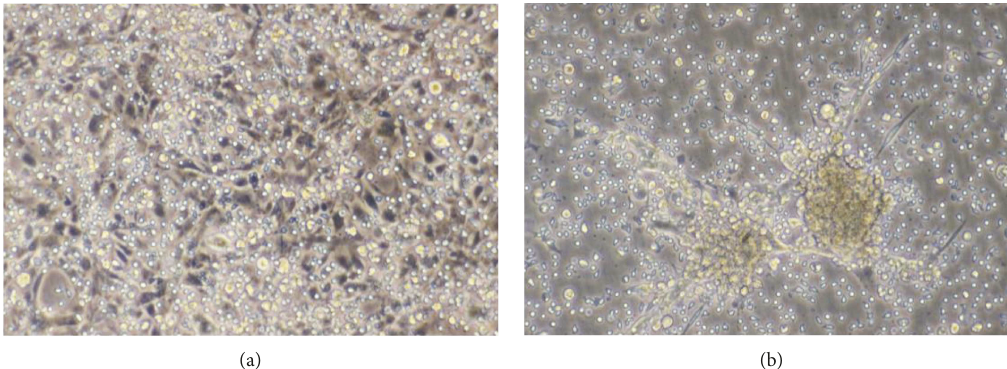
Figure 1: NK cytotoxicity against 2A2 pig endothelial cells. (a) Monolayers of porcine endothelial cells (pEC) were cultured to con fl uence and a suspension of IL2-activated puri fi ed polyclonal NK cells (bright round cells) was added on top of the monolayer, always in the absence of human sera. (b) After 4 hours of coculture with IL2-activated NK cells, the pEC monolayer was destroyed. Pictures were taken with a 200x magni fi